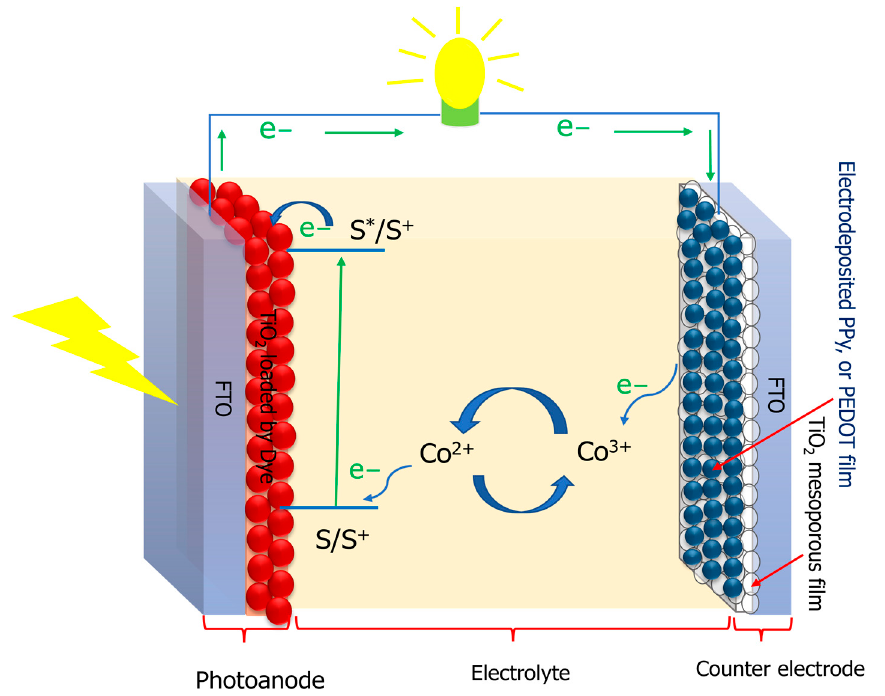
Figure 1. Schematic representation of DSSC device showing photoanode and counter electrode with an electrolyte sandwiched in the gap between them. an electrolyte sandwiched in the gap between